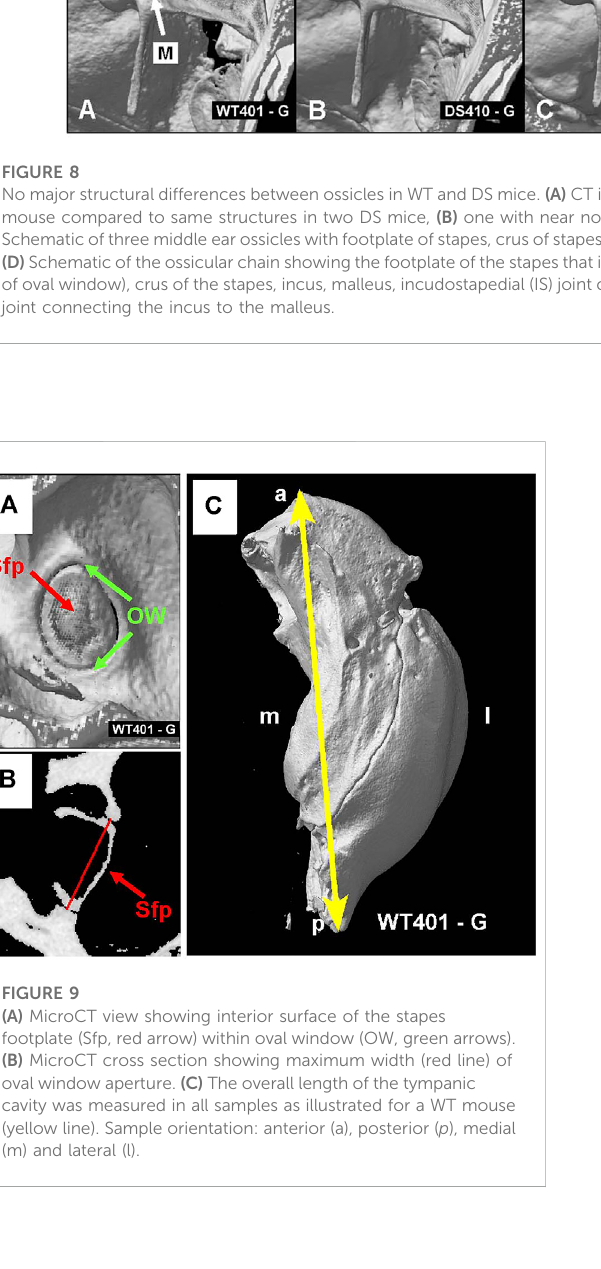
Figure 9A shows the interior surface of the stapes footplate (Sfp, red arrow) which resides within the oval window (OW, green arrows). From the microCT images, we obtained cross